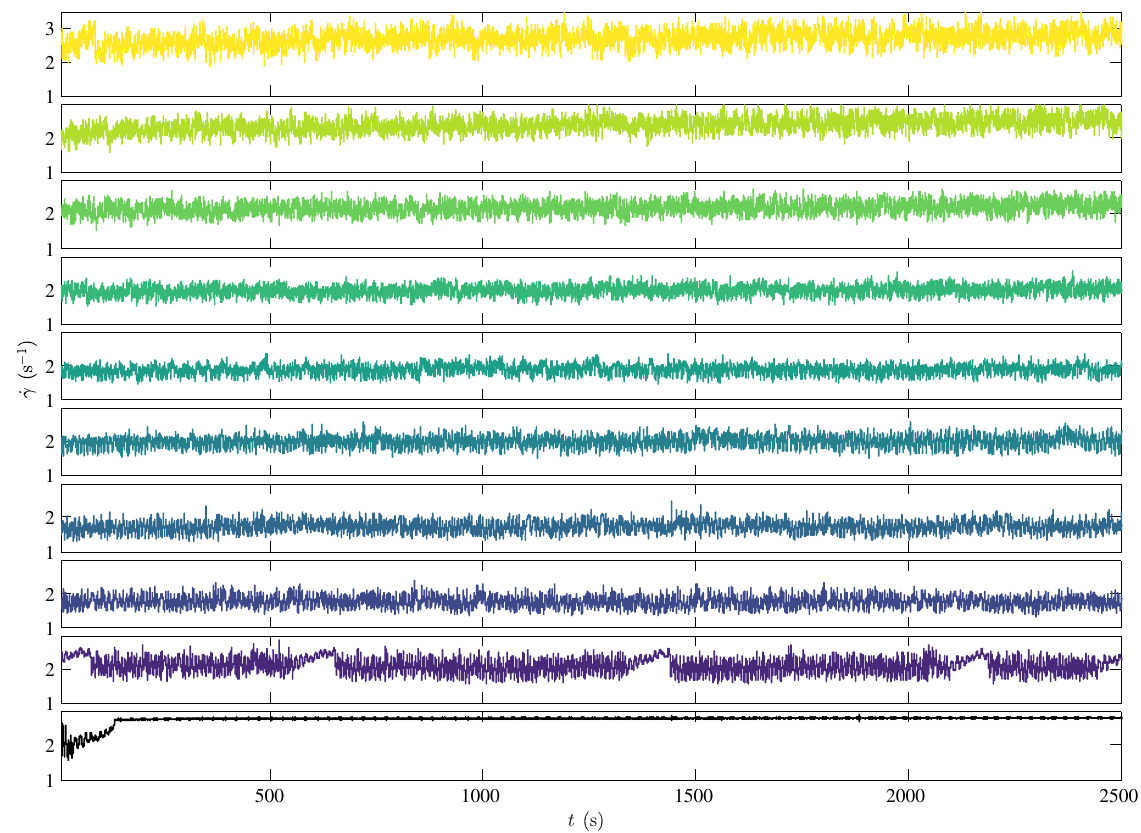
FIG. 11. Time series of the shear rate _ γ ð t Þ recorded under various constant shear stresses imposed at time t ¼ 0 : σ ¼ 11 Pa up to 150 Pa from bottom to top (see color code in Fig.